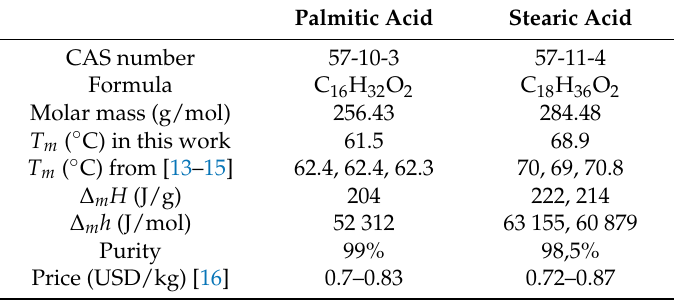
Table 1. General information about the fatty acids used in this study and provided by Sigma-Aldrich (St. Louis, MO,